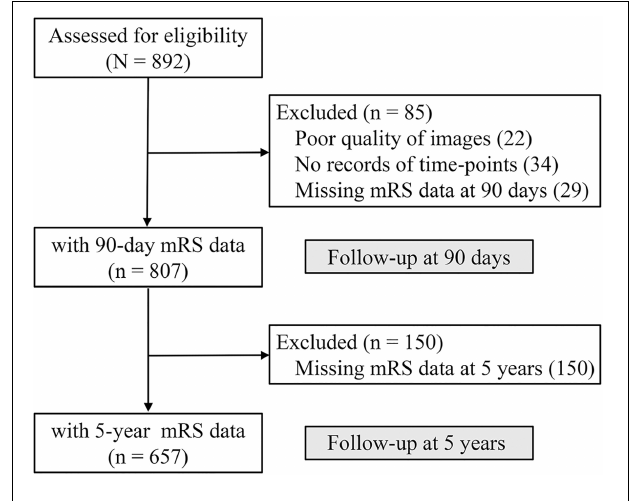
FIGURE 1 | Flow diagram of the study.